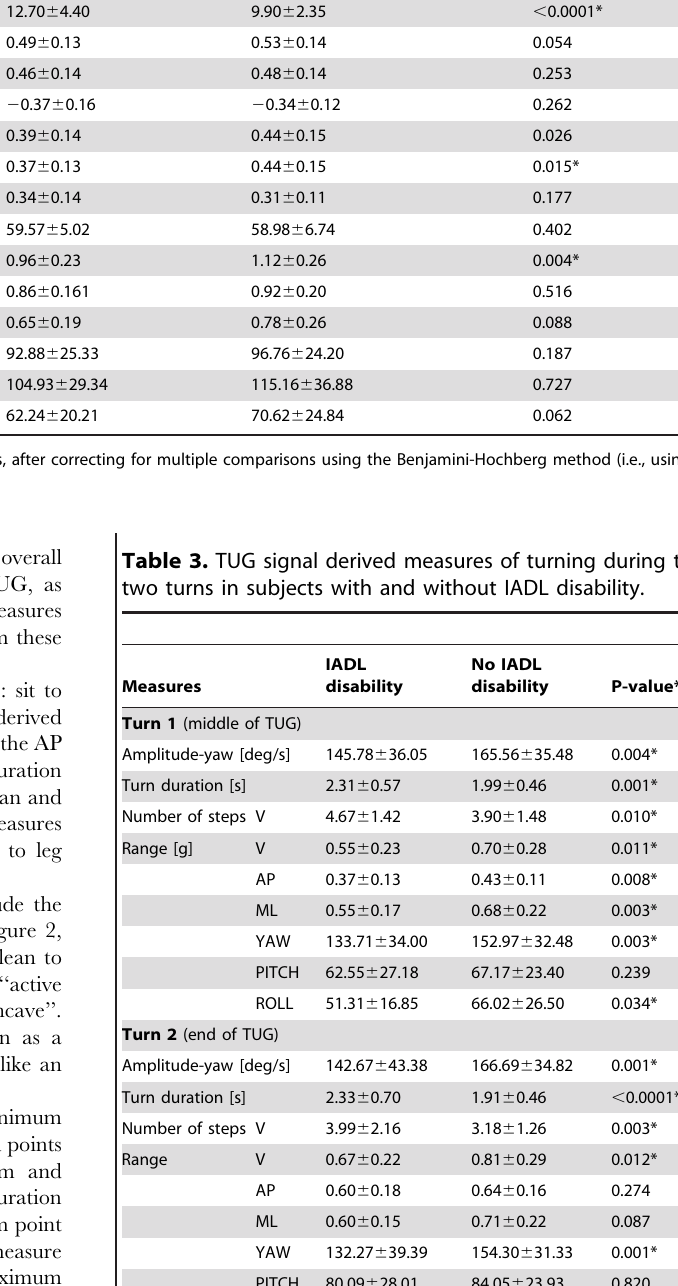
Measures Overall TUG (including all components)